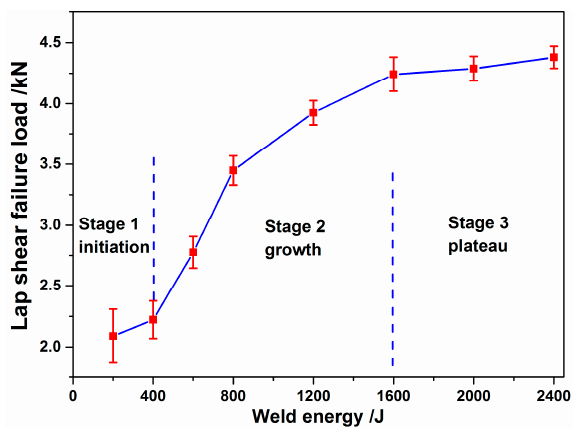
Figure 6. Effect of welding energy on the peak load of as-welded Cu/Cu USW joints.